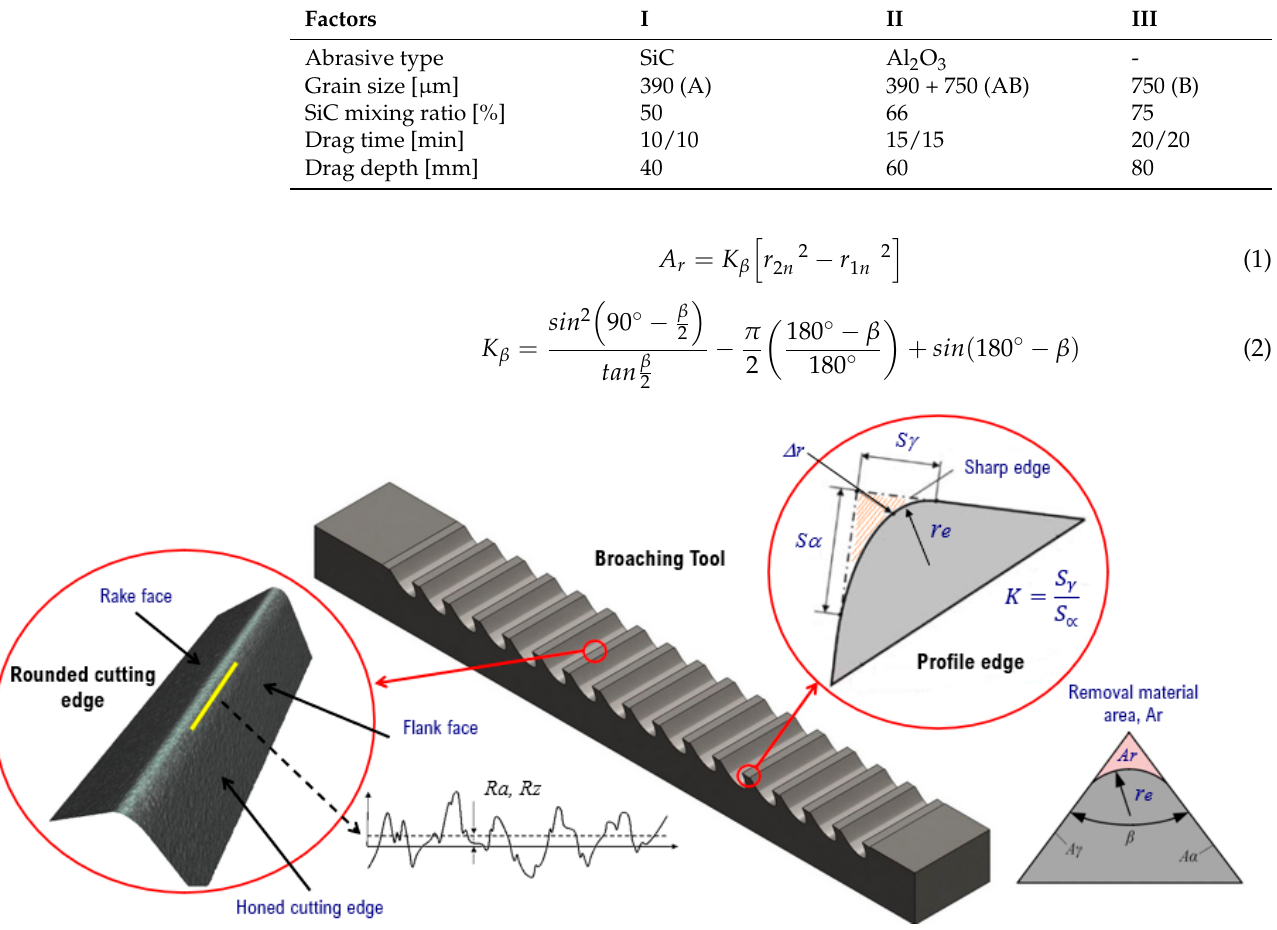
Figure 2. Characterization of the honed cutting